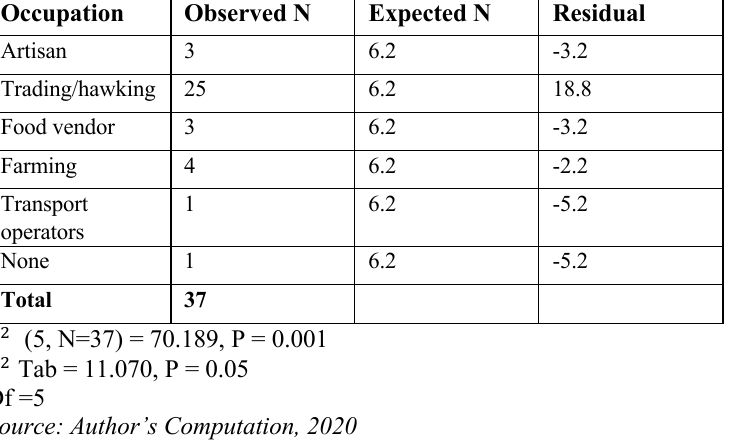
Table 3. Educational attainment of